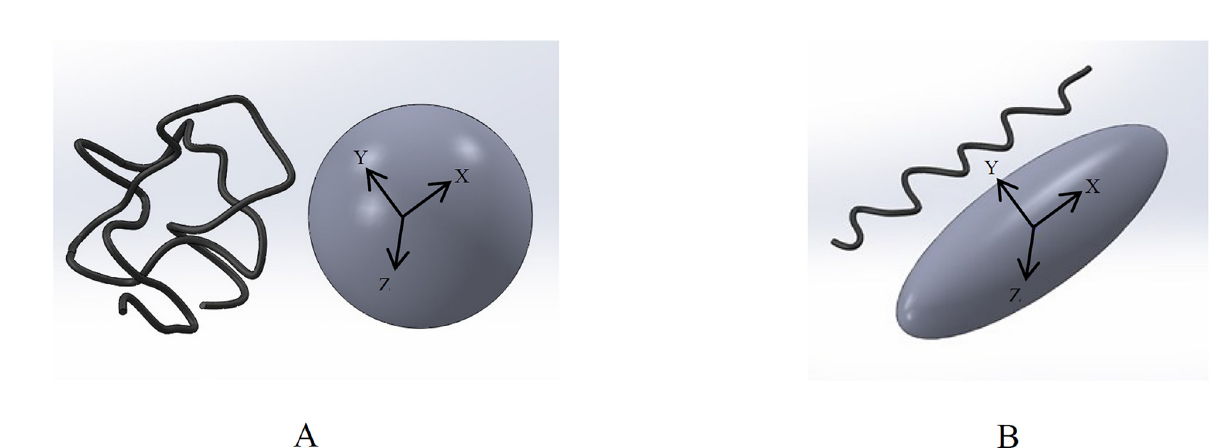
Fig 2. Geometric representation of the diffusion tensors, showing isotropic (A) and anisotropic (B)